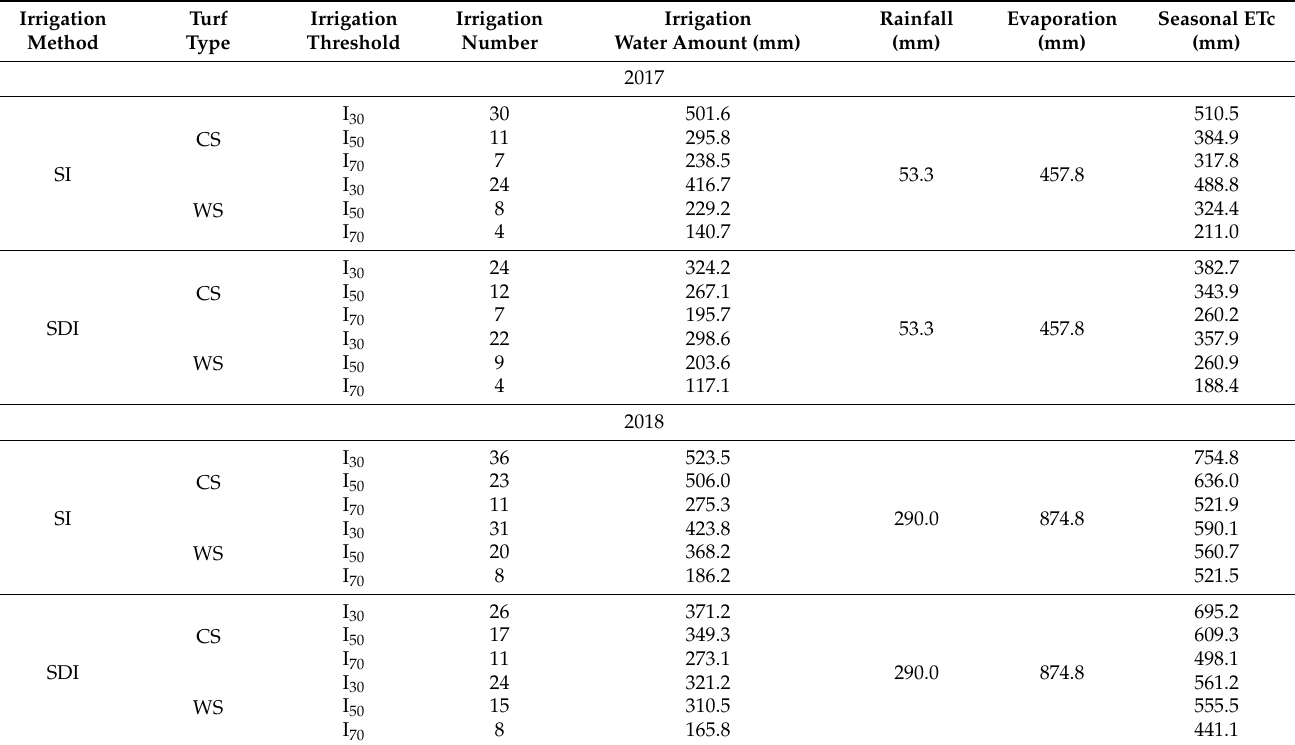
Table 2. Total number of irrigations, total amount of irrigation water applied and seasonal ET c .